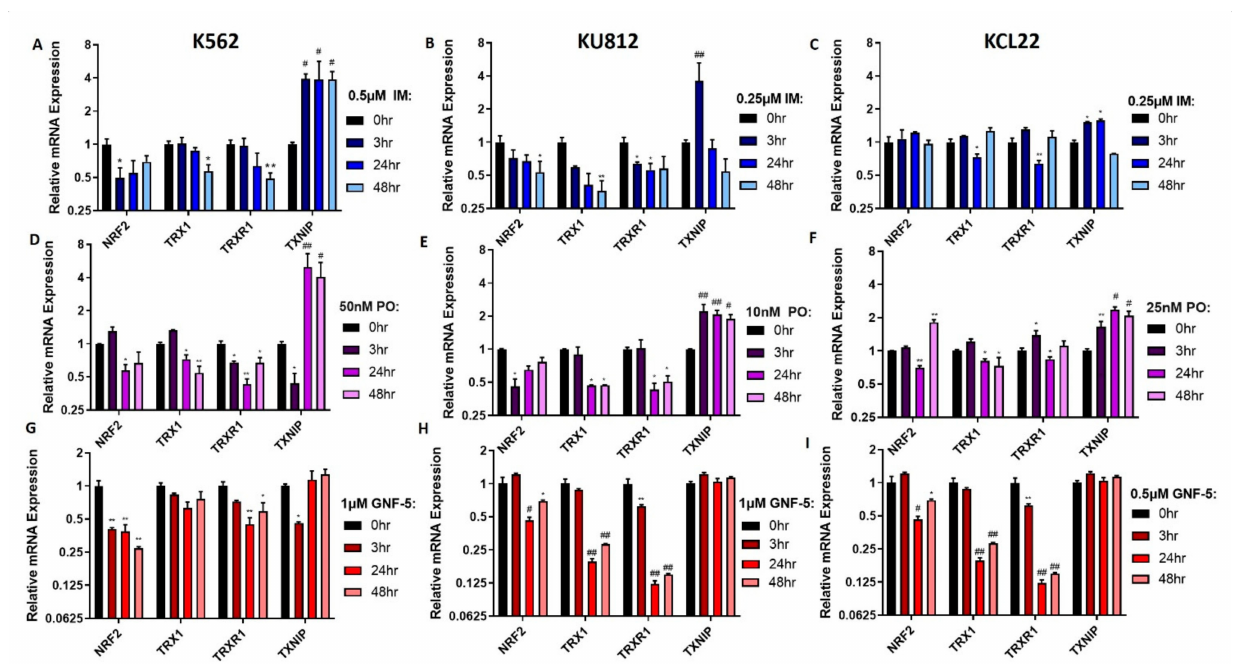
Figure 5. TKIs affect the mRNA expression levels of components of the TRX system. K562, KU812 and KCL22 CML cells were treated with either imatinib ( A – C ), ponatinib ( D – F ) or GNF-5 ( G – I ) for 3, 24 or 48 h. Following this, RT-qPCR was performed and measured the mRNA expression of NRF2 , TRX1 , TRXR1 and TXNIP . RPL32 was used as a normalizer. Results were analyzed via one-way ANOVAs with a Dunnett’s post hoc test. Statistical tests compared results between the treated cells and the untreated control for each cell line. * = p < 0.05, ** = p < 0.01, # = p < 0.001, ## = p < 0.0001. n = 3. Values displayed as mean ±